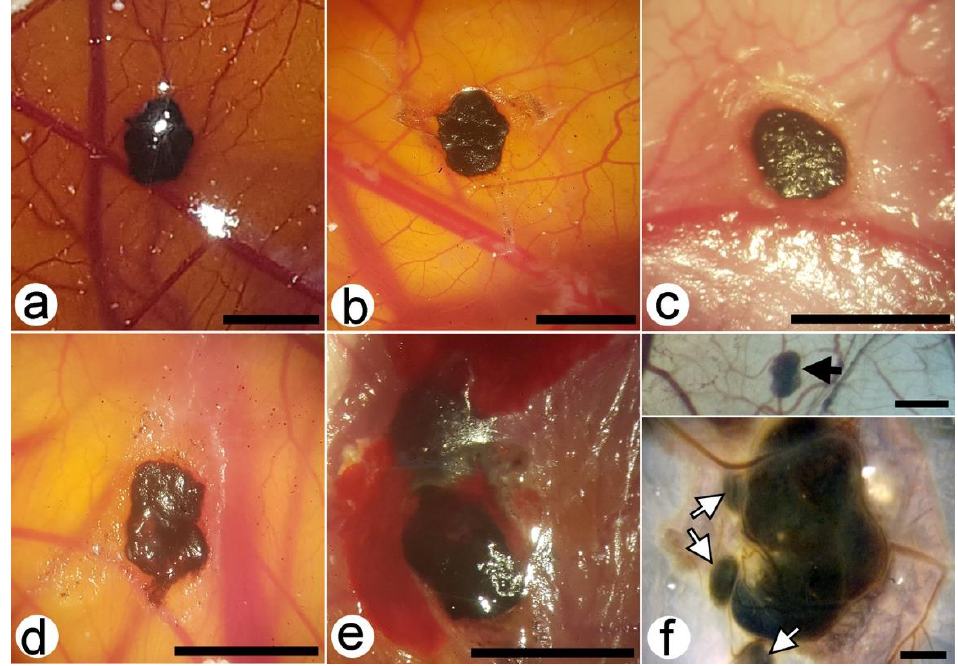
Figure 2. Macroscopic features of treated ( a–c ) and untreated ( d–f ) B16F10 xenografts implanted on nine-day-old CAM. Recent implanted ( a ), two-day-old ( b , d ), and five-day-old ( c , e , f ) B16F10 xenografts. Local ( f , white arrows) and distant ( f , black arrow) metastases arising from an untreated xenograft (formalin fixed CAM, bottom view). Bar = 5 mm ( a–e ); 1 mm ( f ).